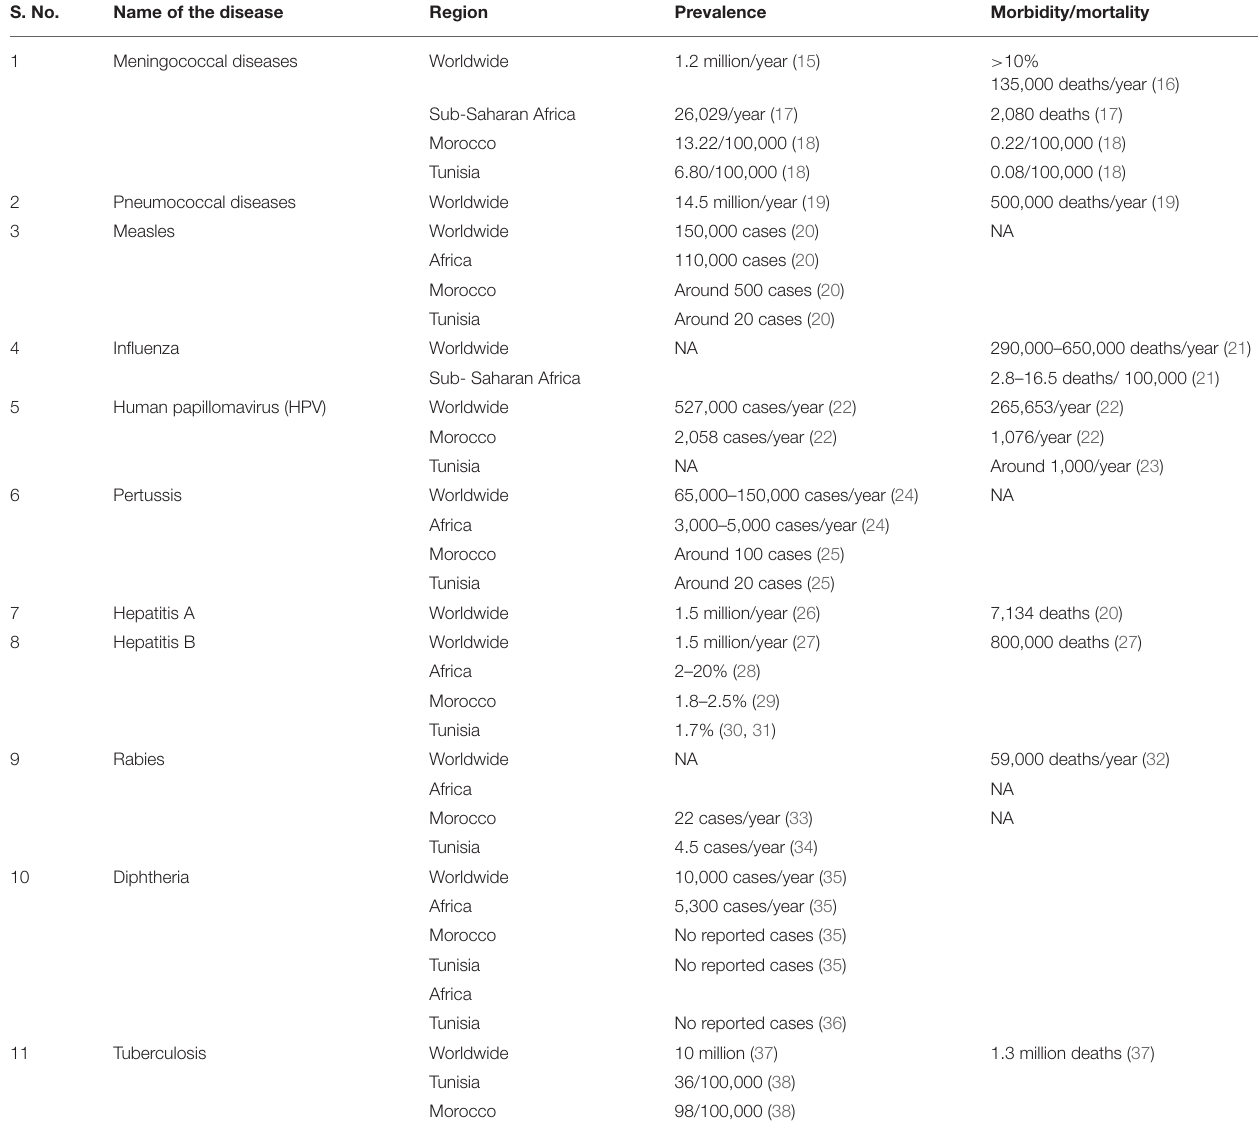
TABLE 1 | Global burden of invasive VPDs. S.